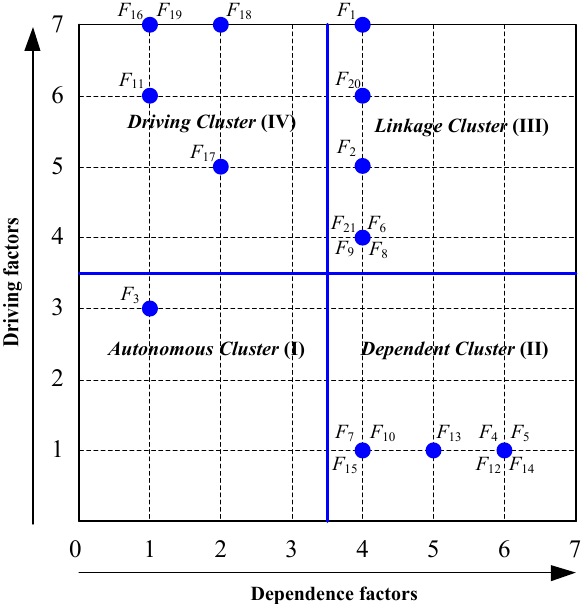
Figure 4. An MICMAC diagram of the representative of gas explosions.